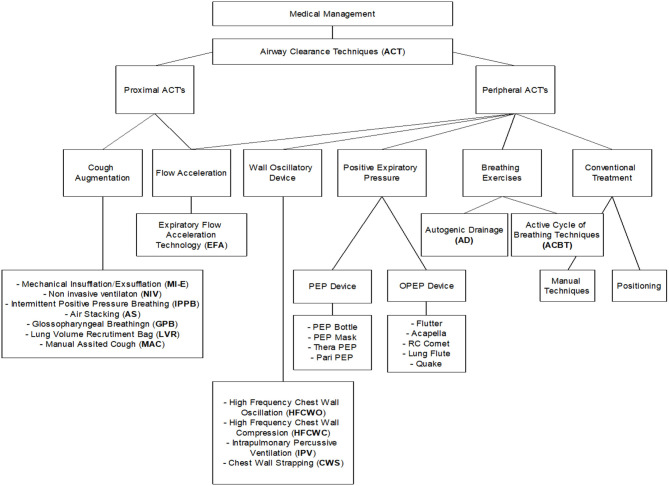
A schematic representation of a proposed algorythm for different ACTs.